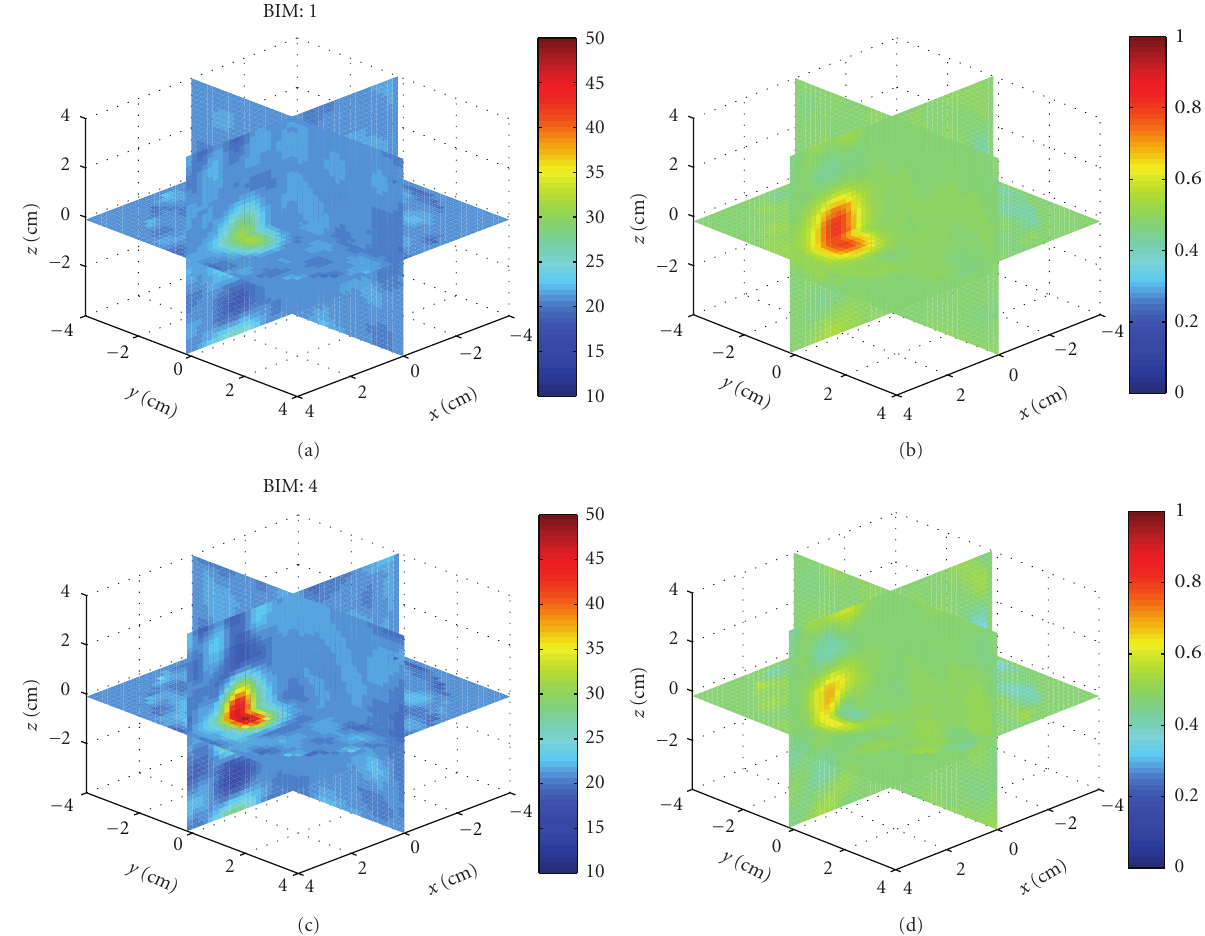
Figure 10: Reconstructions of a single sphere ( (cid:2) r , σ ) = (40, 1) located at ( x , y , z ) = (0,0,2 cm) of Example 1. (a) and (c) and (b) and (d) Relative permittivity and conductivity, respectively. (a) and (b) is the Born approximation. (c) and (d) is BIM iteration 4. Here, iterations help retrieve the relative permittivity in (c), but the Born approximation yielded better conductivity in